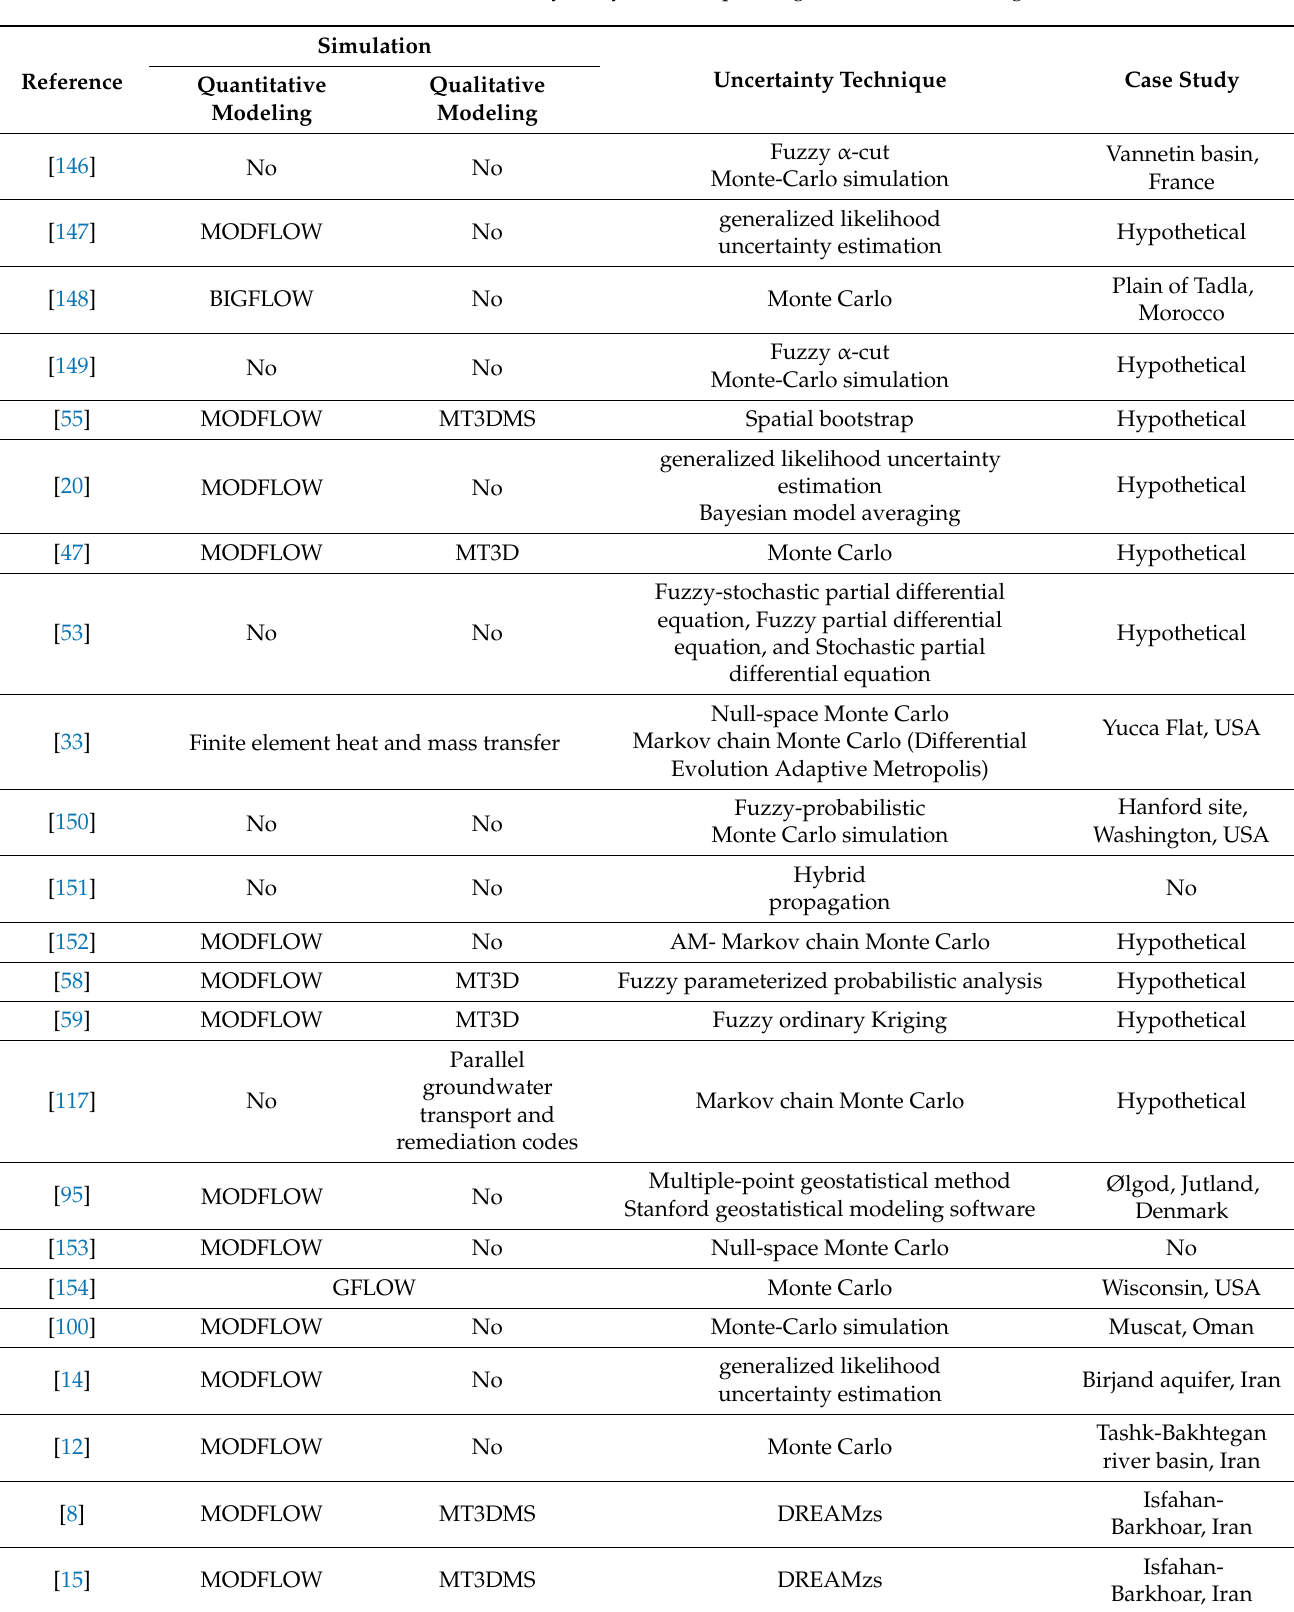
Table 5. The uncertainty analysis techniques in groundwater